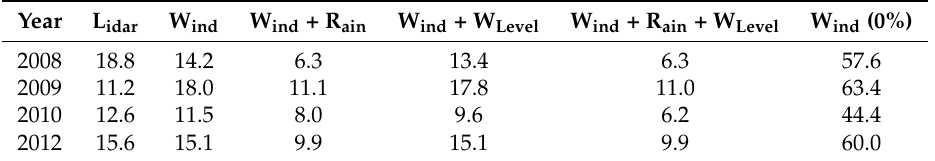
Table 5. Volume change during years in which maximum water level was lower than 2.0 m.